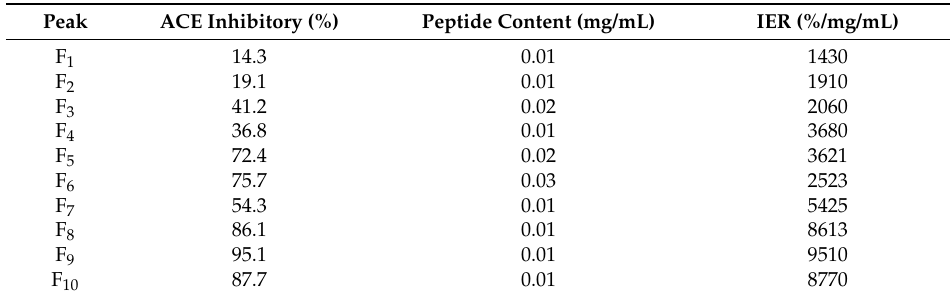
Table 4. ACE IER of peaks isolated from fraction F of